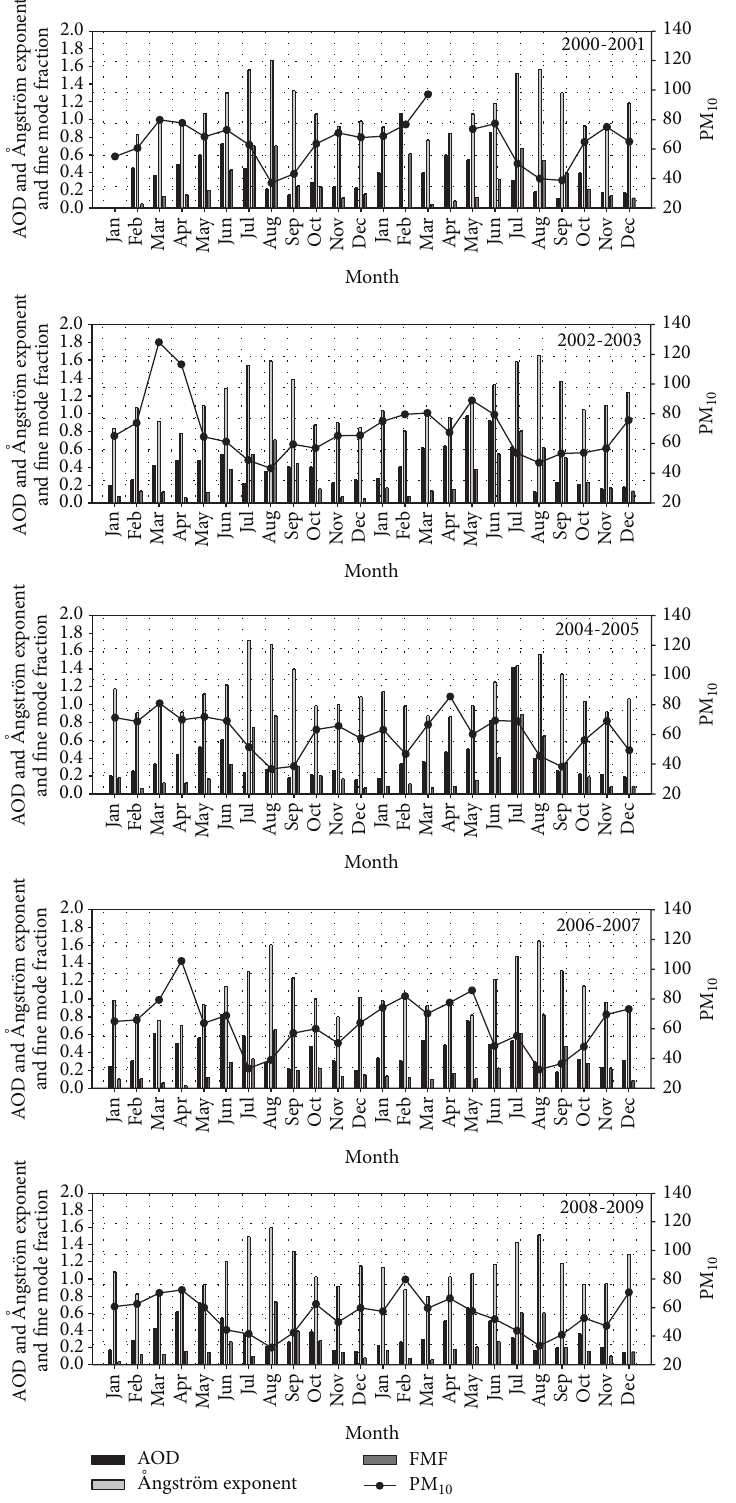
Figure 7: Satellite data (AOD sat , ˚Angstr¨om exponent, and FMF) with PM 10 (2000 to